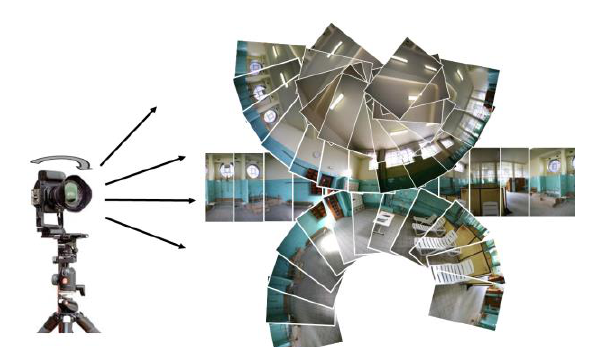
Figure 4: shooting of 49 photographs for composition of panoramic image.